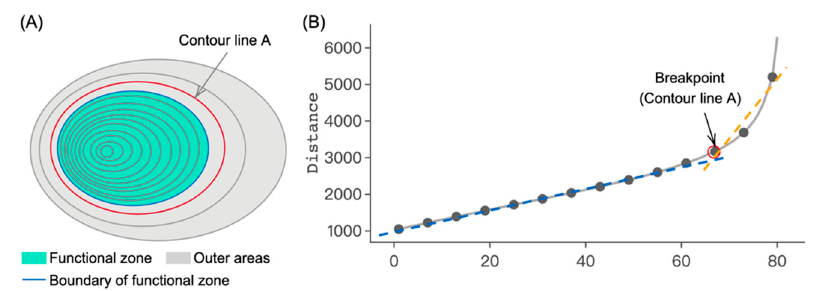
Figure 2. Boundary of the industrial agglomeration area. ( A ) Outline of industrial distribution in the city; ( B ) change trend of the distance between the contour line and its corresponding leaf node.